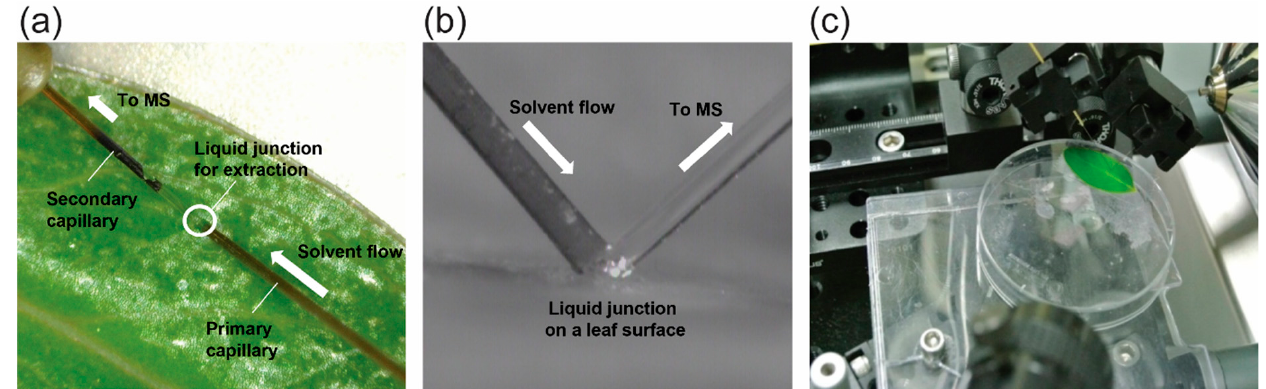
Figure 1. Nano-DESI MS of a Hypericum leaf. A liquid junction of a nano-DESI was in contact with a leaf surface, as seen in the ( a ) top view and ( b ) side view of the nano-DESI probe on the leaf. ( c ) Photo of the homebuilt nano-DESI MS interface for the chemical fingerprinting of plant leaf samples. The time-segmented metabolite fingerprints directly collected from a raw Hypericum leaf surface in the negative ion mode are shown in Figure 2. At the beginning of